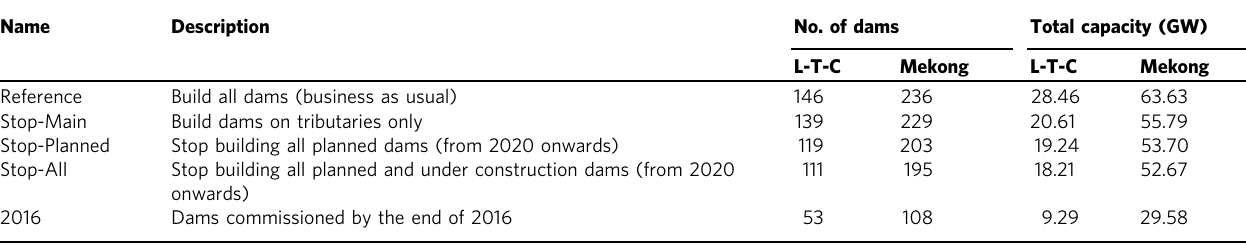
Table 1 Dam development portfolios over the planning horizon 2016 – 2037.